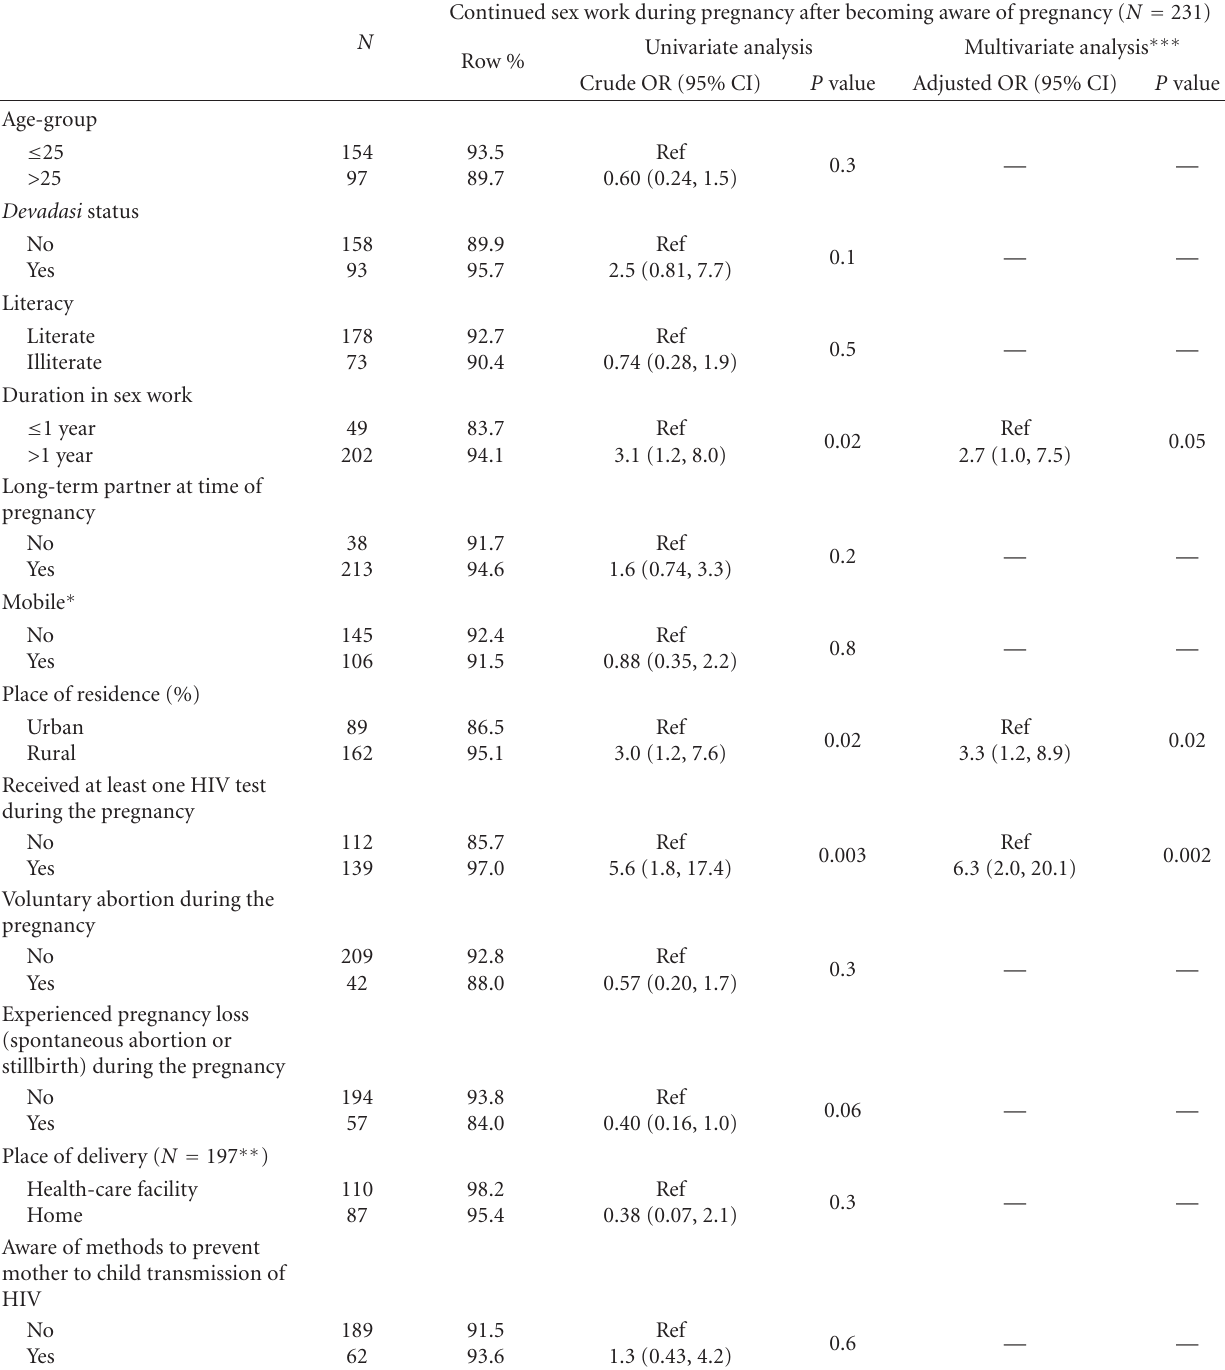
Table 2: Factors associated with ongoing sex work during pregnancy among primiparous female sex workers ( N =